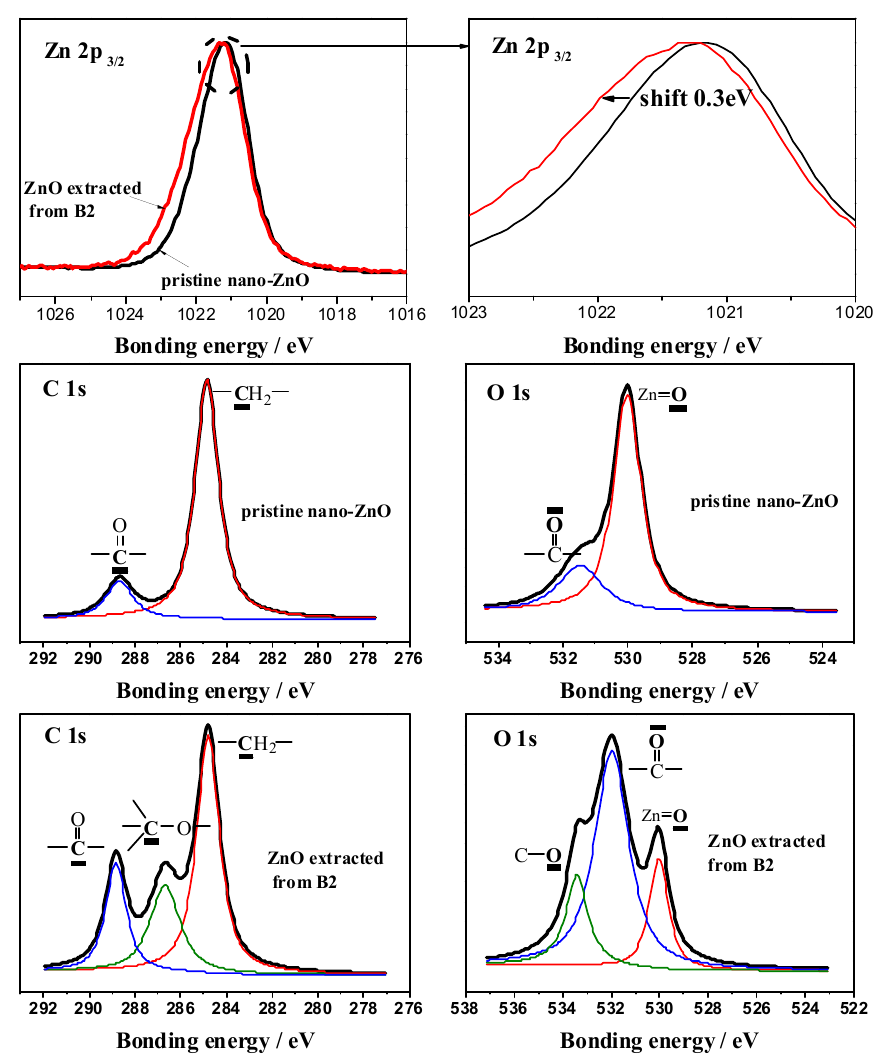
Figure 3. Zn 2p 3/2 , C 1s, and O 1s high-resolution XPS spectra recorded at a 90° takeoff angle for ZnO at room temperature.